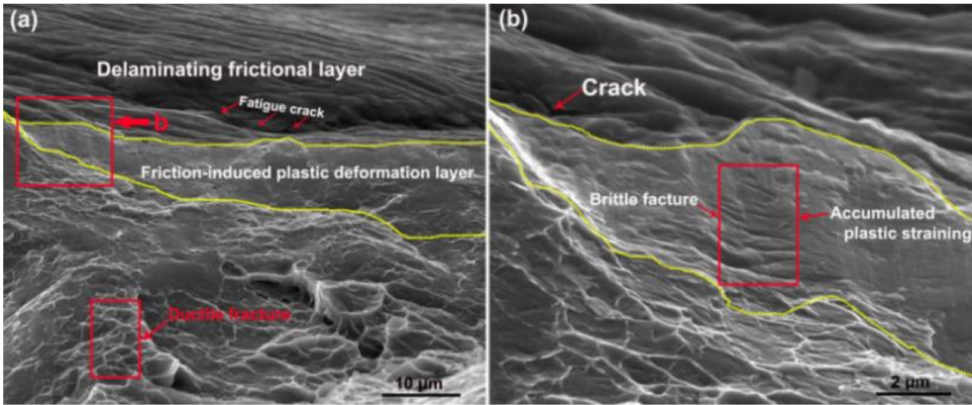
Figure 9. ( a ) cross-sectional SEM image of wear track of material M0, ( b ) enlarged view of ( a